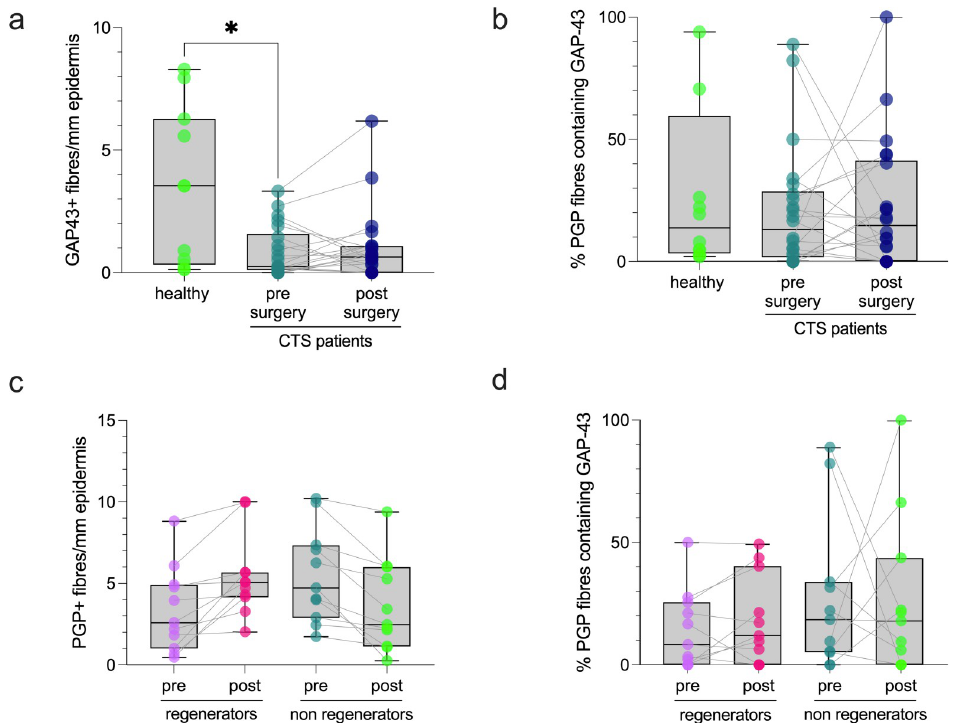
Fig 1. Immunohistochemical staining results of GAP-43 and PGP. (A) Patients with CTS before surgery have fewer GAP-43+ IENF than healthy controls. No changes in GAP-43+ IENFD was apparent from before to six months after surgery in patients with CTS. (B) No difference was apparent in the % of PGP+ IENF containing GAP-43 among healthy participants, patients with CTS before and after surgery. (C) IENFD of patients with CTS classified as regenerators and non-regenerators according to the difference in PGP+ IENFD before and after carpal tunnel surgery. (D) No difference was apparent in the percentage of PGP+ IENF containing GAP-43 between regenerators and non- regenerators both pre- and post-surgery. � p =